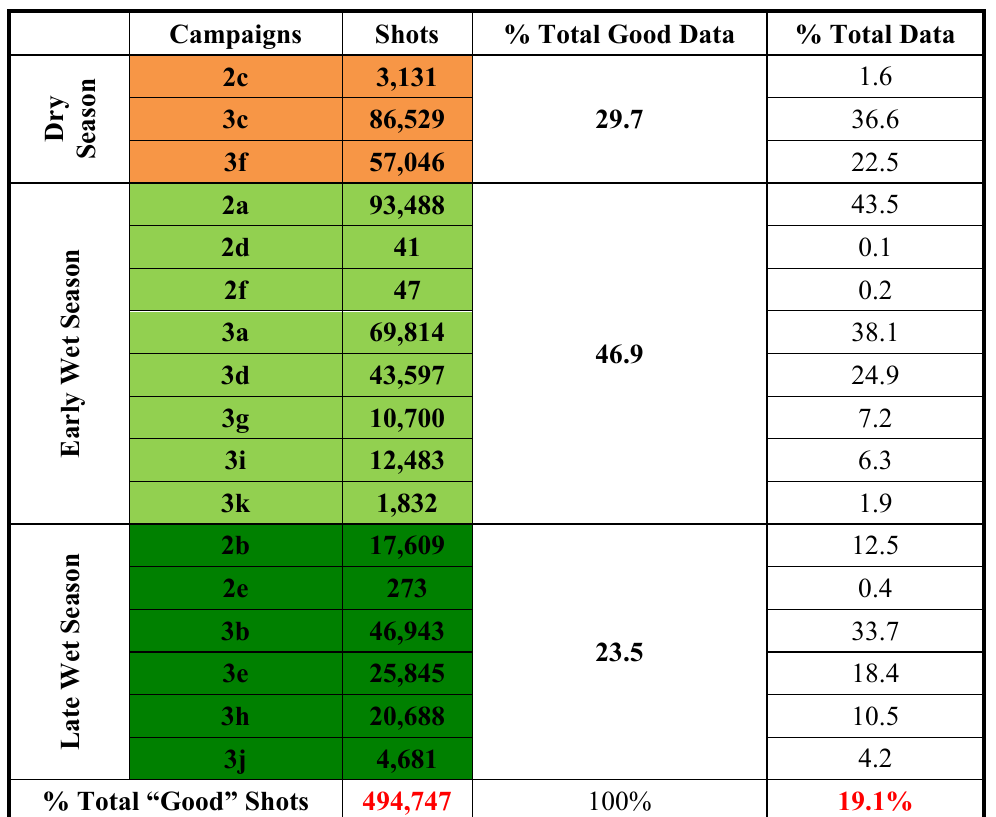
Table 3. Distribution of good LIDAR points ( i.e. , gain value ≤ 30) according to the 17 GLAS campaigns (91-day repeat orbit) and major Cerrado seasonal